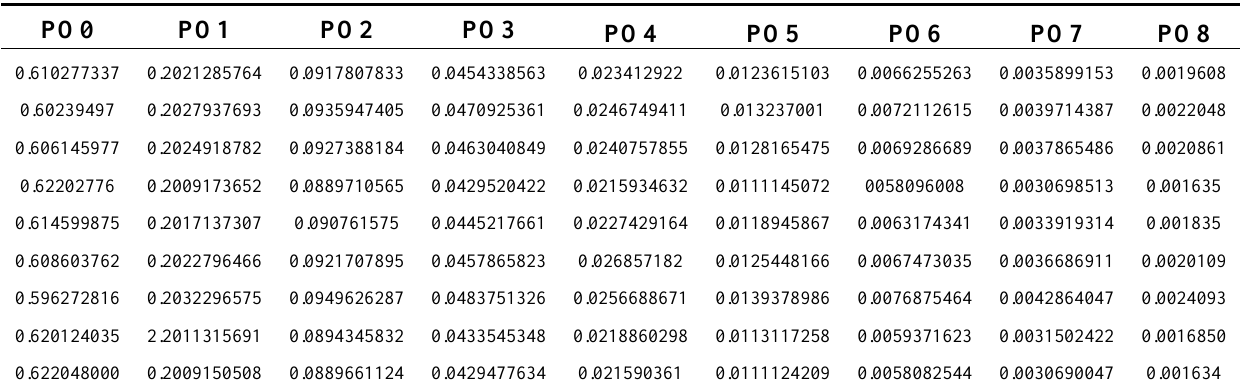
Table 4. Probabilities for the occurrence of N accidents for a sample of sections of 500 m in length.